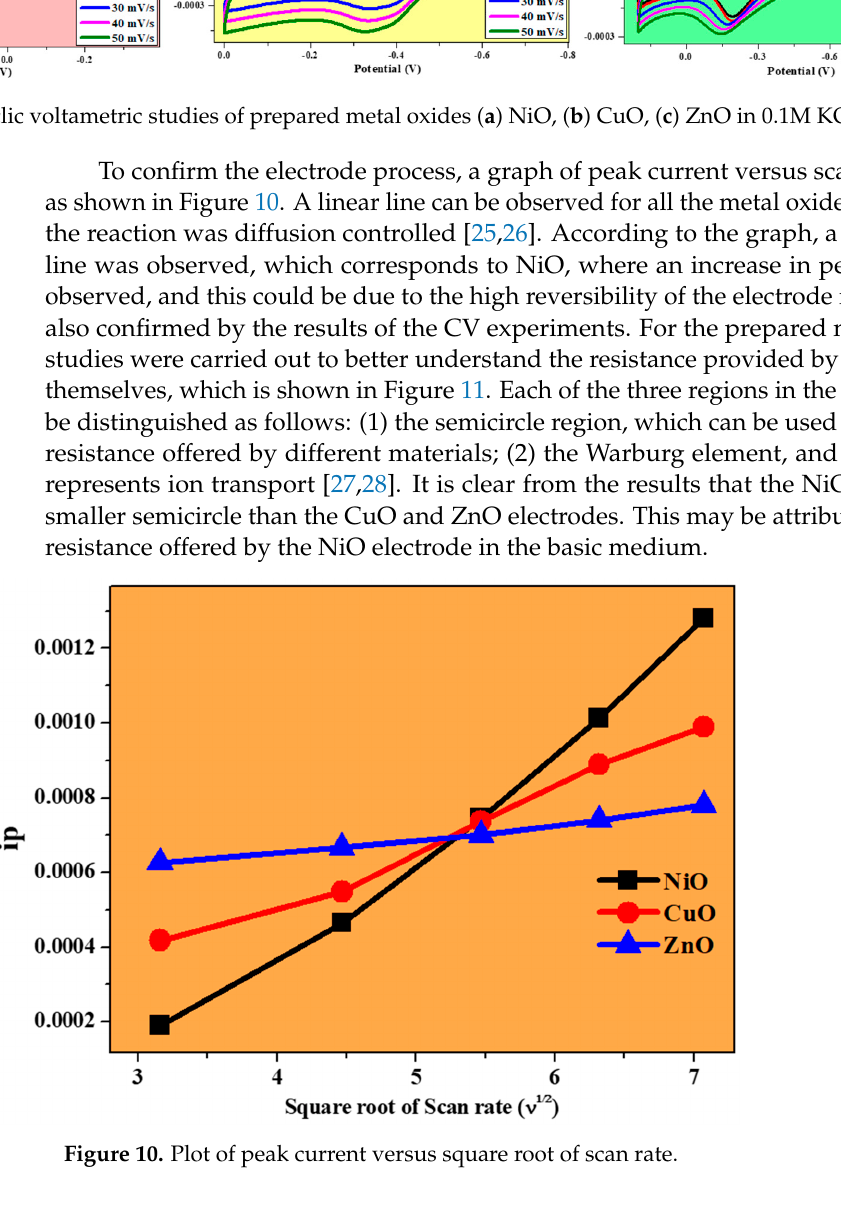
Figure 11. Nyquist plots of the prepared metal oxides. 3.8. Glucose Sensing By using glucose as the analyte, the prepared metal oxides were evaluated for their sensing applicability. Glucose was first dissolved in double-distilled water, and then a known concentration of the glucose solution was added to the electrolyte solution to de- termine its sensing ability. According to the data shown in Figure 12, there is a significant